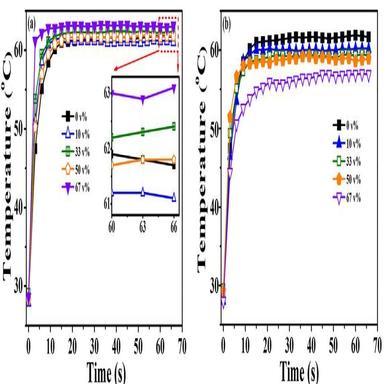
Surface temperature of (a) PVC/CaCO3 composite films and (b) PVC porous films. (temperature of heating platform: about 63 C).